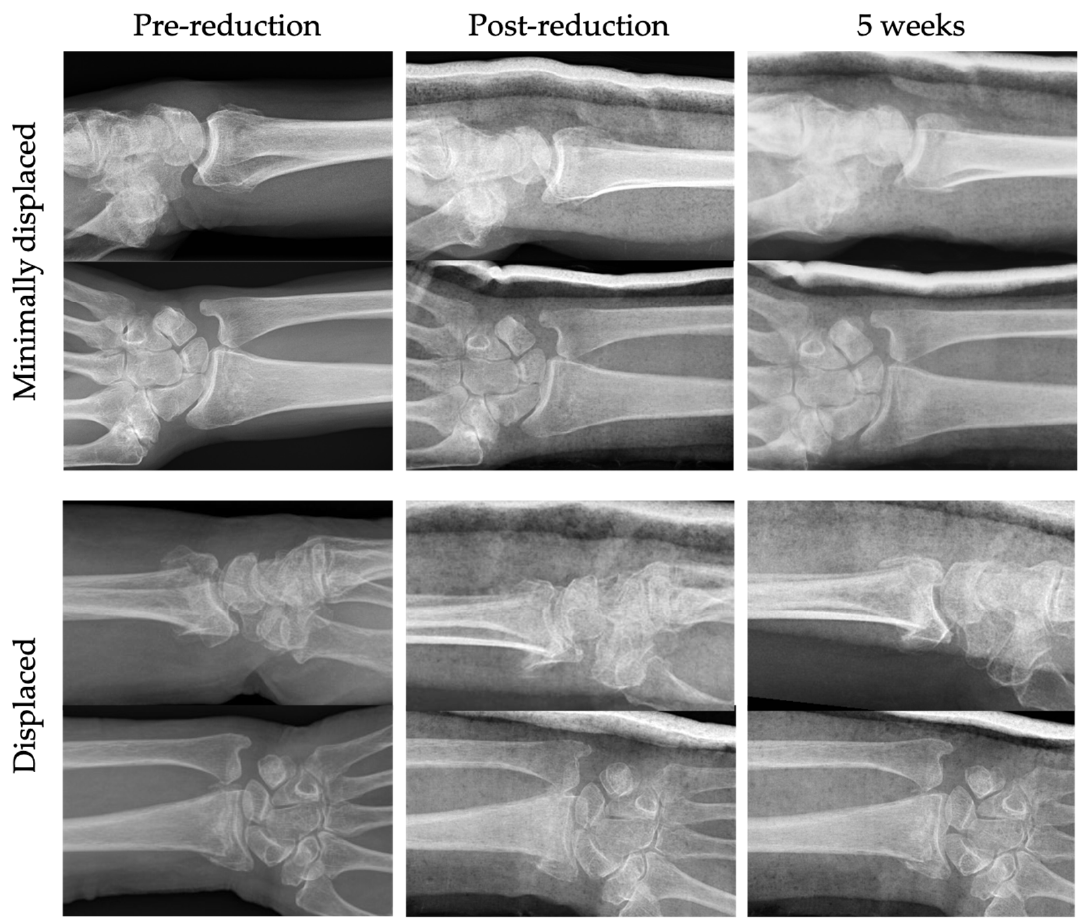
Figure 1. Examples of radiographs of the two non-operatively treated cohorts: minimally displaced distal radius fracture (DRF) and displaced DRF after two attempts of fluoroscopic guided closed reduction. Pre-reduction, post-reduction and 5 week follow up.